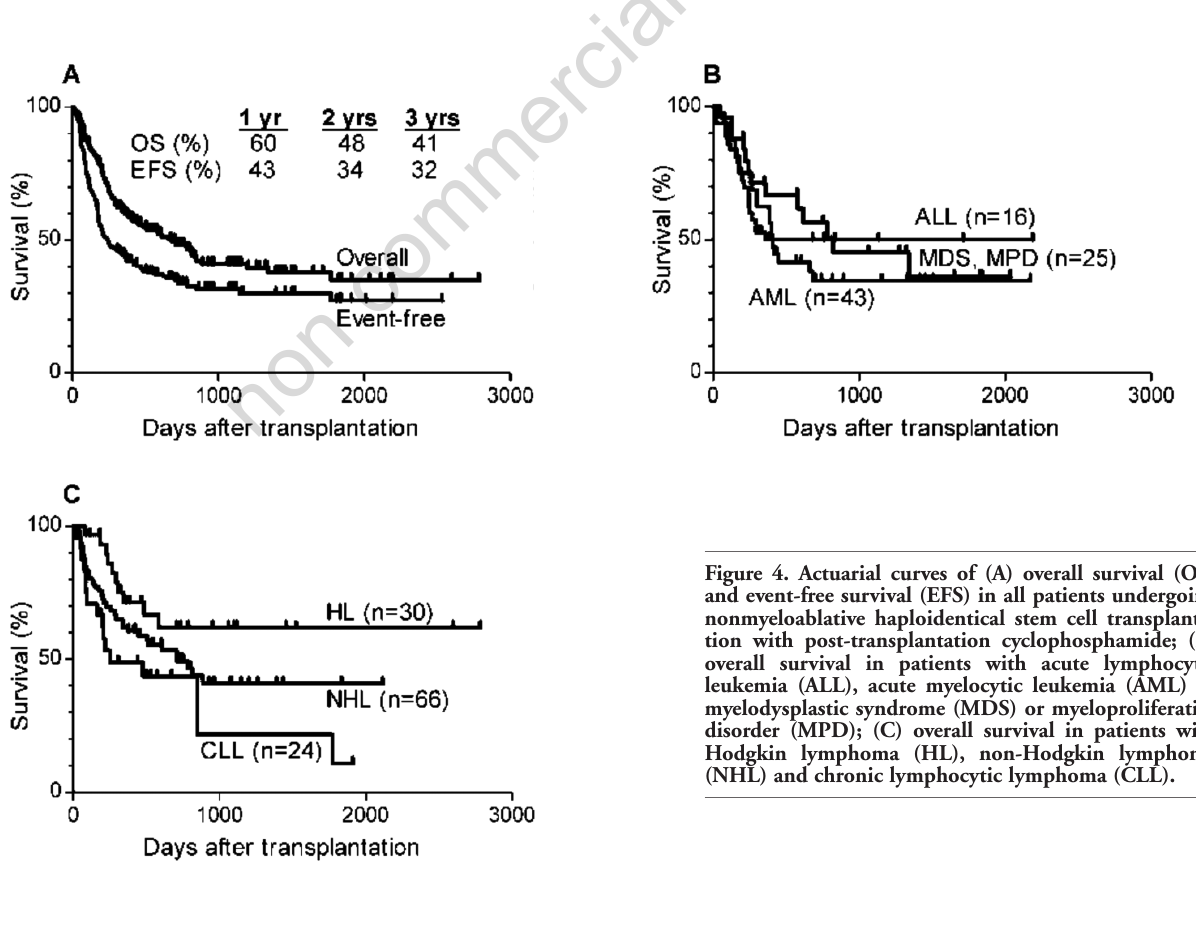
relapse (n=79), infection (n=15), pulmonary